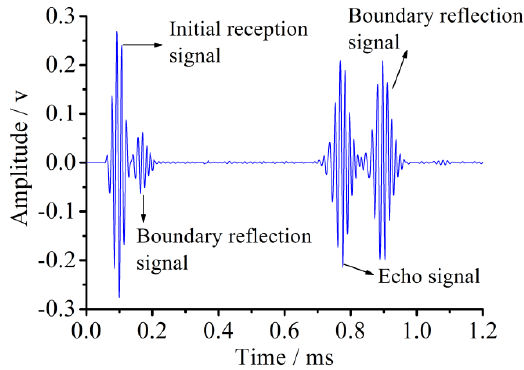
Figure 10. Received signal of the healthy pipe under the new piezoceramic element layout scheme in the simulation.